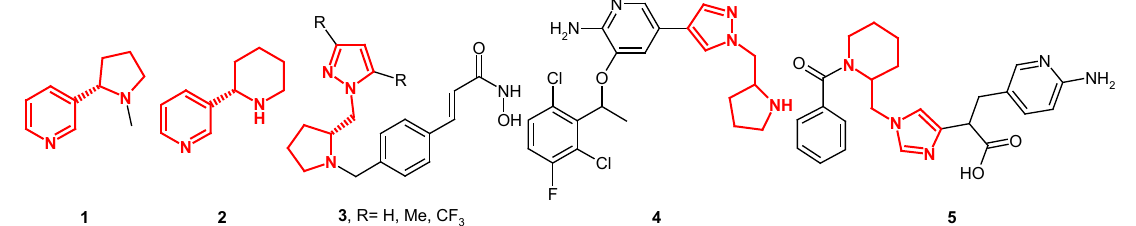
Figure 2. (cid:37)(cid:76)(cid:82)(cid:79)(cid:82)(cid:74)(cid:76)(cid:70)(cid:68)(cid:79)(cid:79)(cid:92)(cid:3)(cid:68)(cid:70)(cid:87)(cid:76)(cid:89)(cid:72)(cid:3)(cid:71)(cid:72)(cid:85)(cid:76)(cid:89)(cid:68)(cid:87)(cid:76)(cid:89)(cid:72)(cid:86)(cid:3)(cid:82)(cid:73)(cid:3)(cid:87)(cid:75)(cid:72)(cid:3)(cid:86)(cid:70)(cid:68)(cid:73)(cid:73)(cid:82)(cid:79)(cid:71)(cid:86)(cid:3)(cid:71)(cid:72)(cid:287)(cid:81)(cid:72)(cid:71)(cid:3)(cid:76)(cid:81)(cid:3)(cid:41)(cid:76)(cid:74)(cid:17)(cid:3) 1 (the scaffolds are shown in